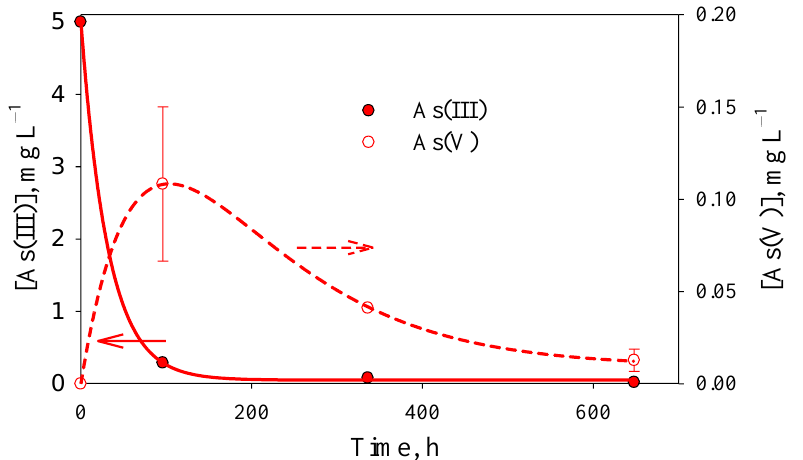
Figure 4. Temporal profiles of As(III) and As(V) concentrations in contact with µ Fe(0). Conditions: [As(III)] 0 = 5 mg L − 1 , [ µ Fe(0)] = 1 g L − 1 , pH 7, RT, EC = 0.03 mS cm − 1 , without stirring. Error bars rep- resent the standard deviation between duplicates, while the full line is the adjustment to Equation (3). The dashed line is only for visualization and does not correspond to any adjustment equa- tion.